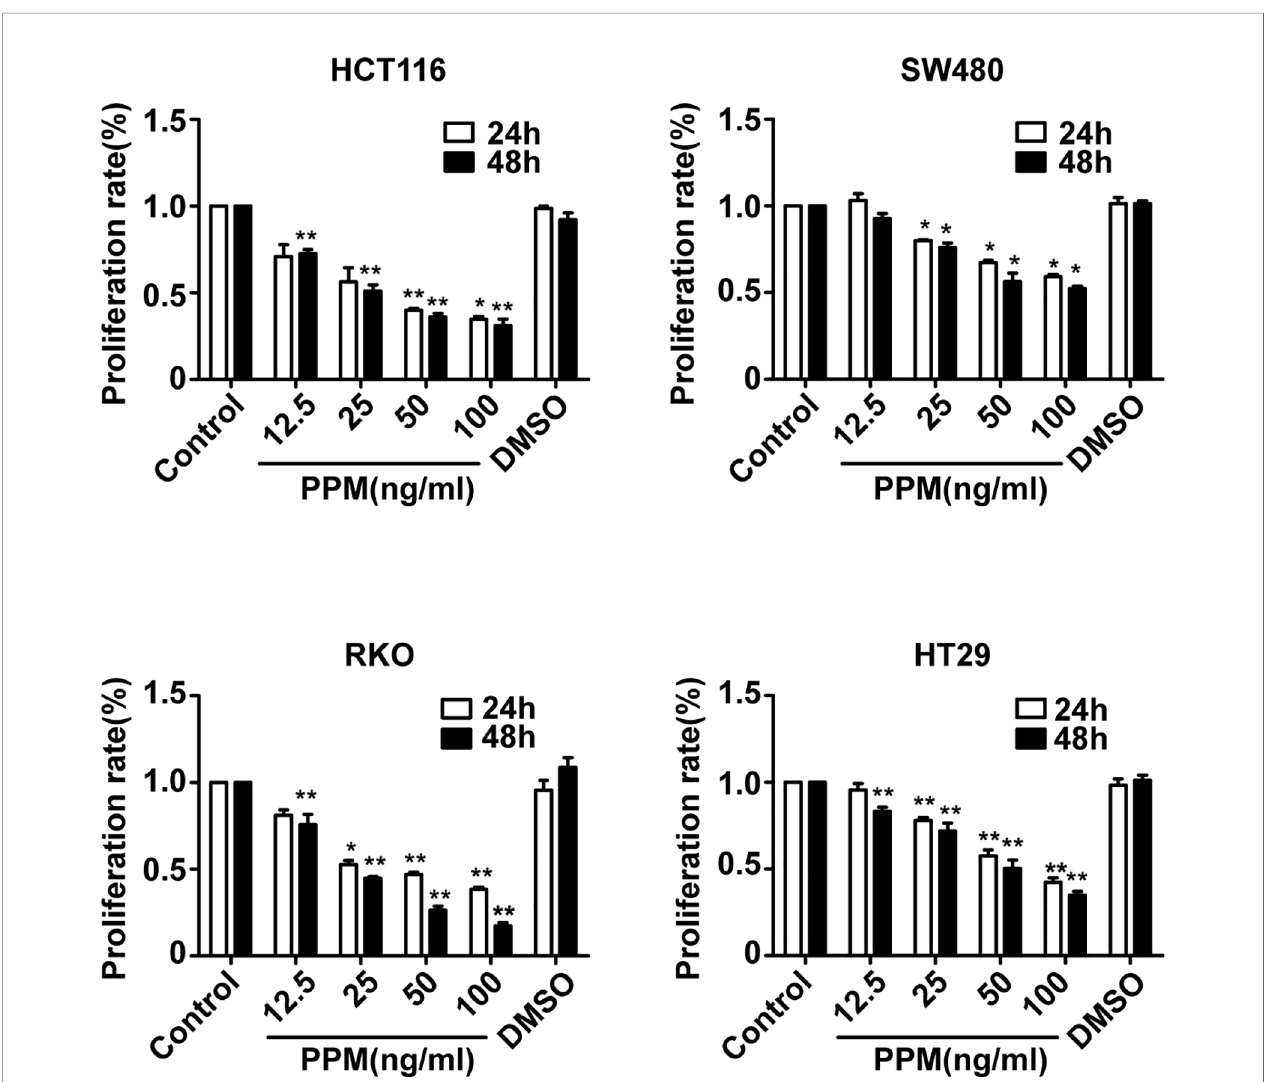
FIGURE 1 | The effect of periplocymarin (PPM) on the viability of colorectal cancer cells. Colorectal cancer cells (HCT 116, SW480, RKO, and HT-29) were treated with different concentrations of PPM (0, 12.5, 25, 50, or 100 ng/ml) and 0.01% DMSO for 24 and 48 h. Cell viability was determined by CCK-8 assays. Data are shown as means ± SEM. * P < 0.05, ** P < 0.01, vs . untreated control